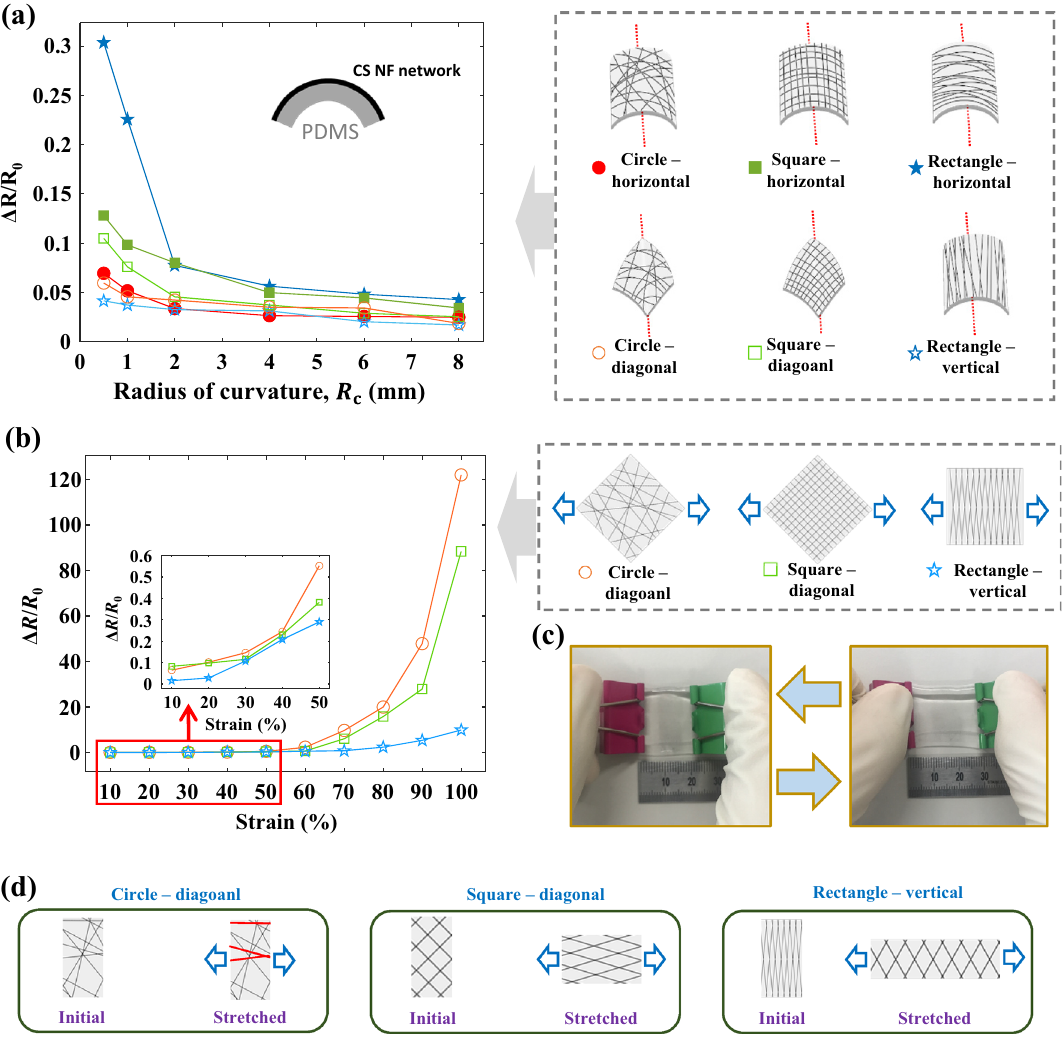
Figure 4. Mechanical durability evaluations of the CS NF networks obtained using the circular, square, and rectangular electrode collectors. ( a ) � R / R 0 values of the CS NF networks after 1000 cycles of bending and releasing at various bending radii (the radii of curvature, R c ). The bending directions with respect to the topologies of the nanofiber networks are shown in the schematic diagrams. ( b ) � R / R 0 values of the CS NF networks after 10 cycles of stretching and releasing at various strains. The stretching directions with respect to the topologies of the nanofiber networks are shown in the schematic diagrams. ( c ) Images showing the stretching and releasing of a CS NF network on a PDMS substrate. ( d ) Schematic diagrams showing the rearrangements of PVDF nanofibers under stretching. The PVDF nanofibers shown in red are highly strained under tensile